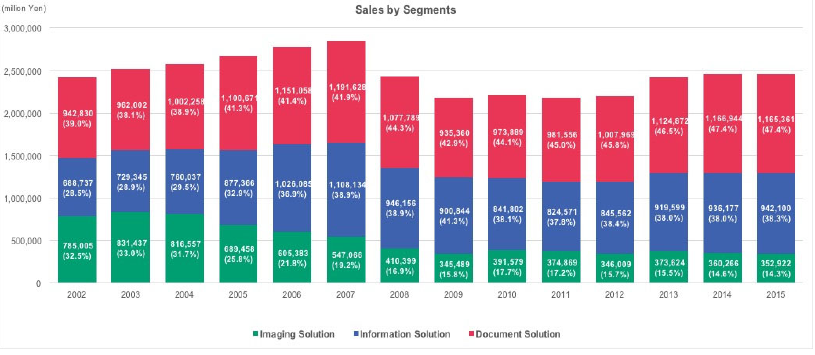
Figure 1. Sales by